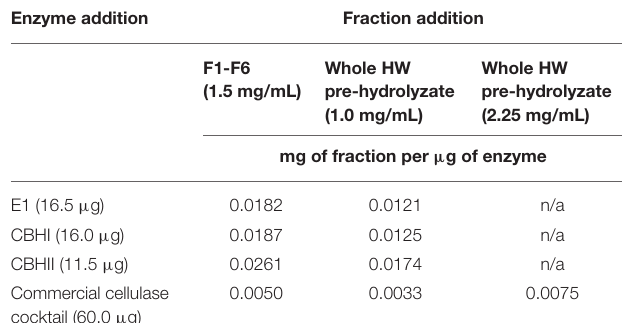
TABLE 2 | Composition of cellulose-DNS assay with a total volume of 200 µ